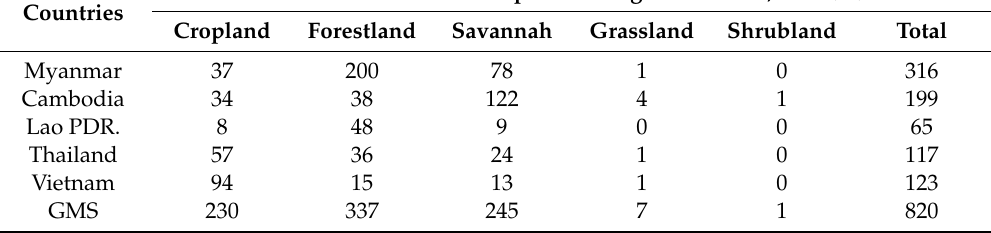
Table A8. The actual amount of PM2.5 from biomass open burning classified by vegetation types in the GMS in 2015. Countries